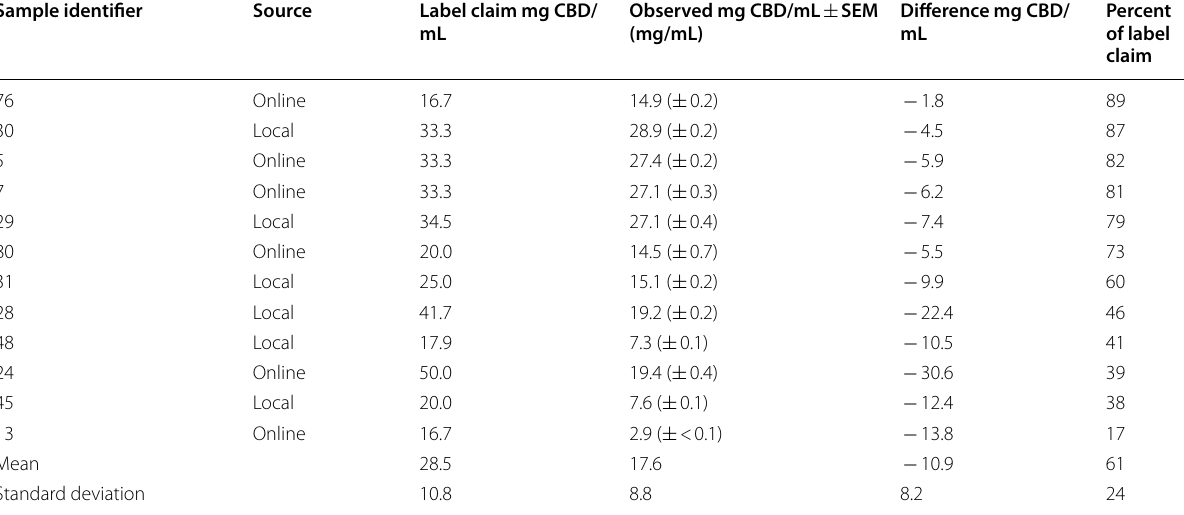
Table 3 List of samples containing at least 10% less CBD than label claim (i.e., over-labelled samples) Sample